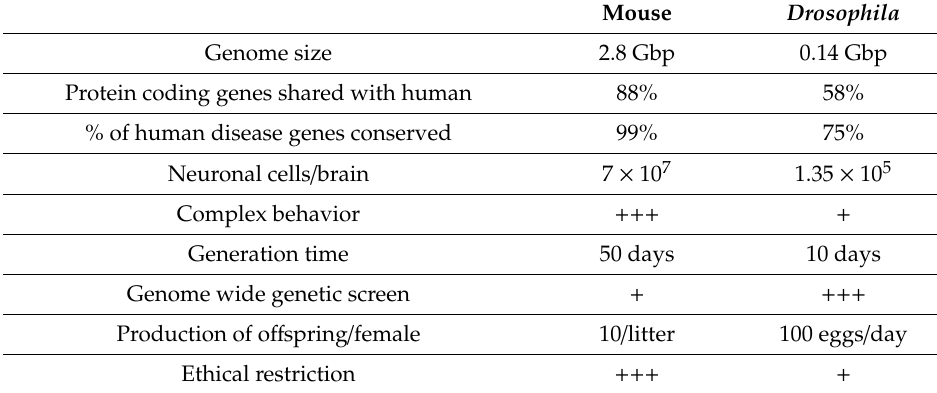
Table 1. Comparison of mouse ( M. musculus ) and Drosophila ( D. melanogaster ) as model organism.